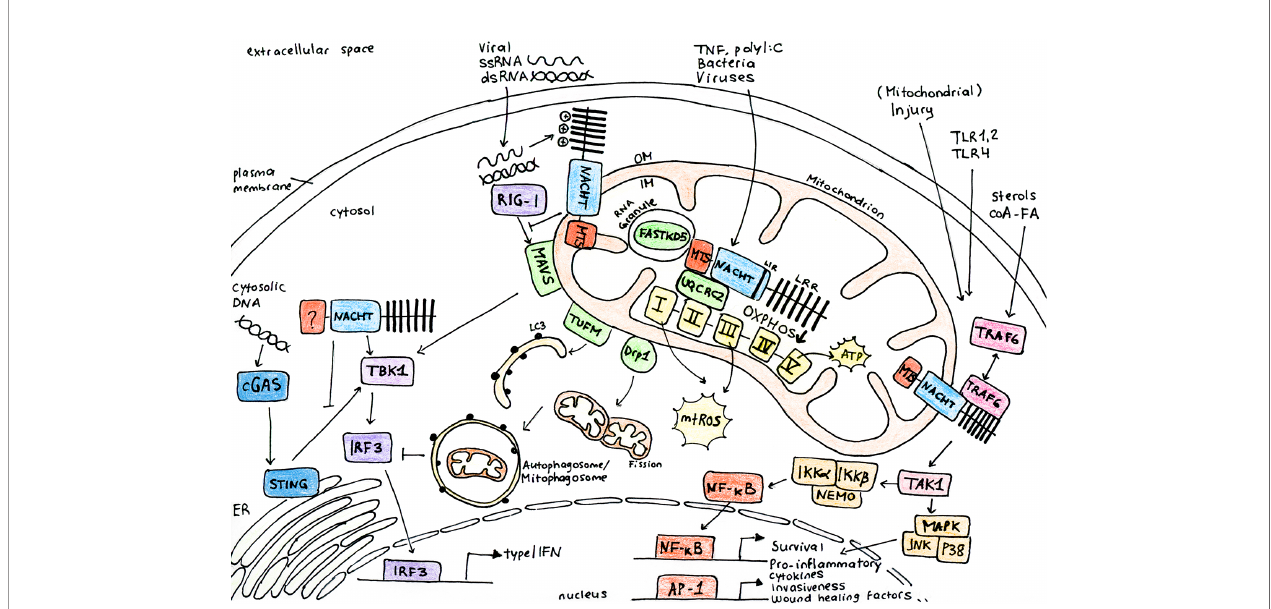
FIGURE 1 | NLRX1 regulates multiple cellular pathways to control in fl ammation in response to infection and stress. NLRX1 is addressed to the mitochondria via the N-terminal mitochondrial targeting sequence (MTS). Studies identi fi ed a C-terminal RNA-binding element and coherently, NLRX1 plays a role in anti-viral signaling by inhibition of type I interferon signaling through direct interaction with the outer membrane (OM) mitochondrial anti-viral signaling protein (MAVS). However, some studies describe that NLRX1 attenuates viral replication in the cytoplasm via a MAVS-independent mechanism, potentially through binding of stimulator of interferon genes (STING). Inhibition of type I IFN signalling following virus infection is associated to enhanced autophagy and mitophagy through association of NLRX1 with either the Tu translation elongation factor (TUFM) or GTPase dynamin-related protein 1 (DRP1). Similarly, NLRX1 is associated to enhanced mitochondrial reactive oxygen species (mtROS) production and decreased oxygen consumption and mitochondrial oxidative phosphorylation (OXPHOS) following virus or bacterial infection through interaction with the mitochondrial protein ubiquinol-cytochrome c reductase core protein II (UQCRC2). Growing interest has been attributed to the role of NLRX1 as a modulator between in fl ammation and metabolism. Following cellular stress, NLRX1 inhibits activation of NF- k B through its direct interaction with TRAF6 or I k B kinase (IKK) complex. NLRX1 may indeed play a more general role in the maintenance of mitochondrial physiology and cellular homeostasis. AP-1, activator protein 1; cGAS, cyclic GMP-AMP synthase; ER, endoplasmic reticulum; FASTKD5, FAST kinase domain-containing protein 5; IKKa, I k B kinase subunit a ; IKKb, I k B kinase subunit b ; IM, inner membrane; IRF3, interferon regulatory factor 3; JNK, c-Jun N-terminal kinase; LC3, microtubule-associated protein 1A/1B-light chain 3; LIR, LC3-interacting domain; LRR, leucine rich repeat domain; MAPK, mitogen-activated protein kinase; NACHT, central nucleotide-binding oligomerization domain; NEMO, NF- k B essential modulator; NF- k B, nuclear factor kappa-light-chain-enhancer of activated B cells; p38, p38 mitogen activated protein kinase; RIG-I, retinoic acid-inducible gene I; TAK1, transforming growth factor- b activated kinase-1; TBK1, TANK-binding kinase 1; TRAF6, TNF receptor-associated factor